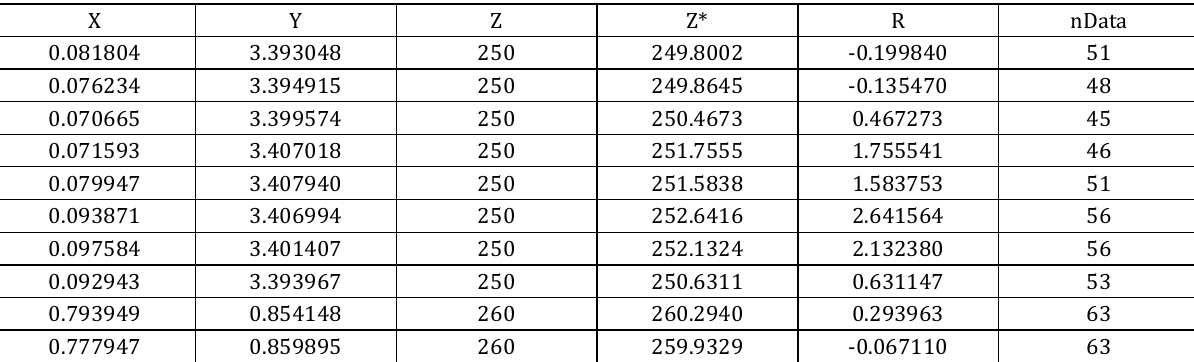
Fig. 5. The empirical variogram and the variogram of combined spherical models and the “nugget effect” model (blue line – combined theoretical models) Table 7. Parameters of 10 selected sampling points received as a result of cross-validation usage based on repeatedly performed variogram setups (X,Y – Cartesian coordinates of real points, Z – height value in XY points, Z* – estimated value, R – residuum, nData – number of neighbours )